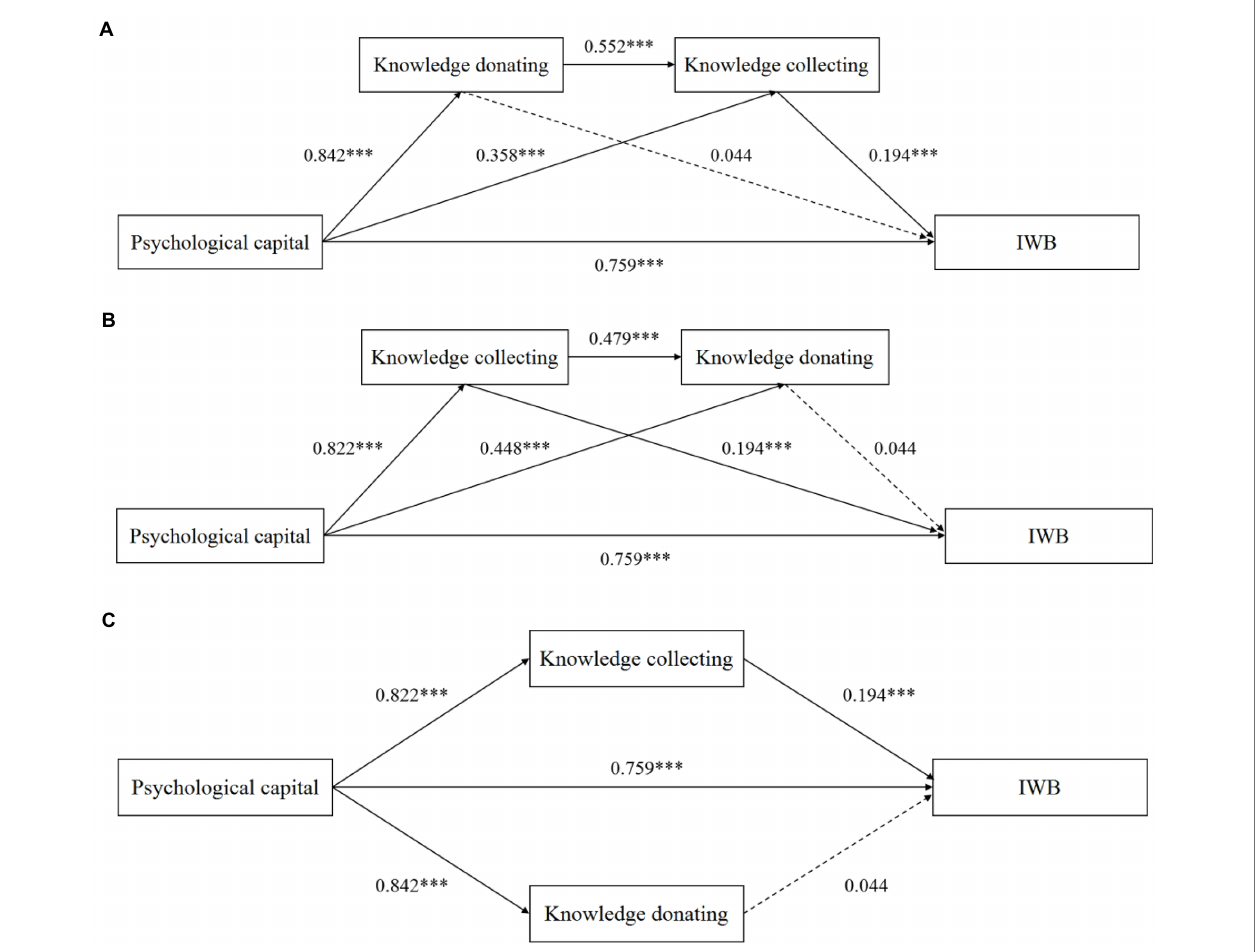
FIGURE 1 | Competitive models of the mediating effects of knowledge collecting and knowledge donating. (A) Knowledge donating and knowledge collecting play a chain mediating role in the relationship between psychological capital and IWB. (B) Knowledge collecting and knowledge donating play a chain mediating role in the relationship between psychological capital and IWB. (C) Knowledge collecting and knowledge donating play a parallel mediating role in the relationship between psychological capital and IWB. Dashed lines indicate that the path is not significant. *** p <